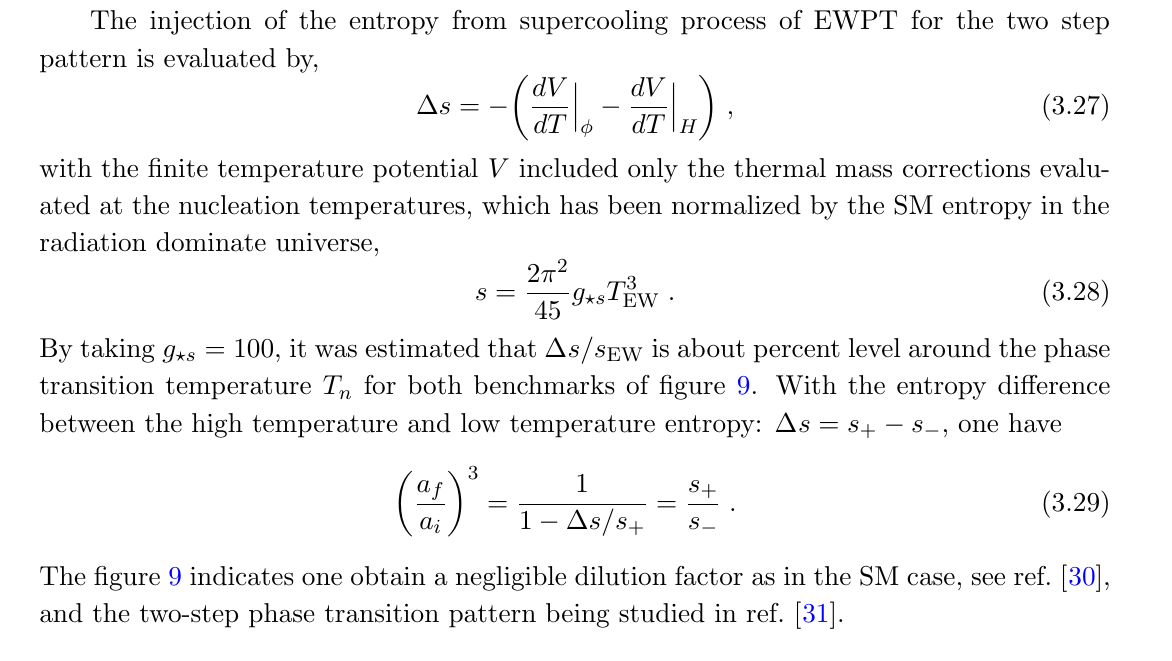
Figure 2 . The entropy deviation for the benchmarks of (cid:12)gure 7 (BP1) and (cid:12)gure 8 (BP2). small amounts of reheating by the release latent heat of the transition. We do not expect the phase coexistence stage for